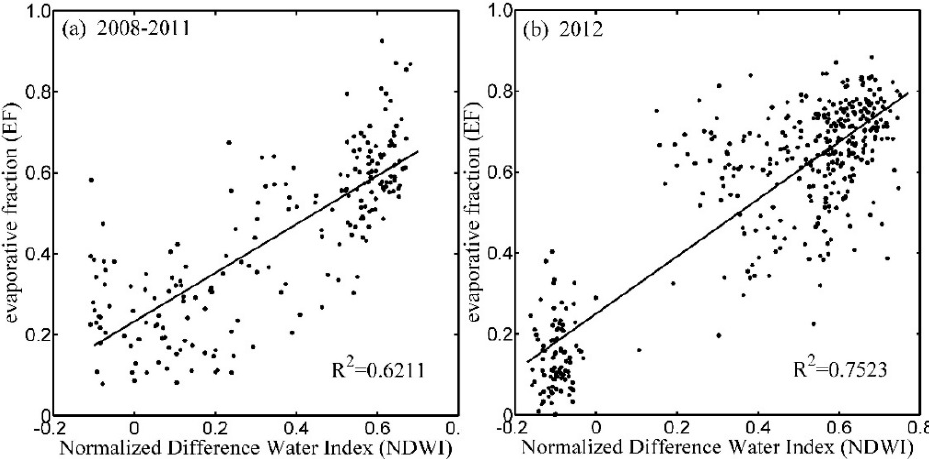
Figure 3. Relationships between the normalized difference water index (NDWI) and evaporative fraction (EF) at ( a ) the Yingke station during the WATER experiment (2008–2011) and ( b ) sixteen HiWATER stations (2012). EF is the evaporative fraction of the clear-sky daytime averages of the EC measurements.